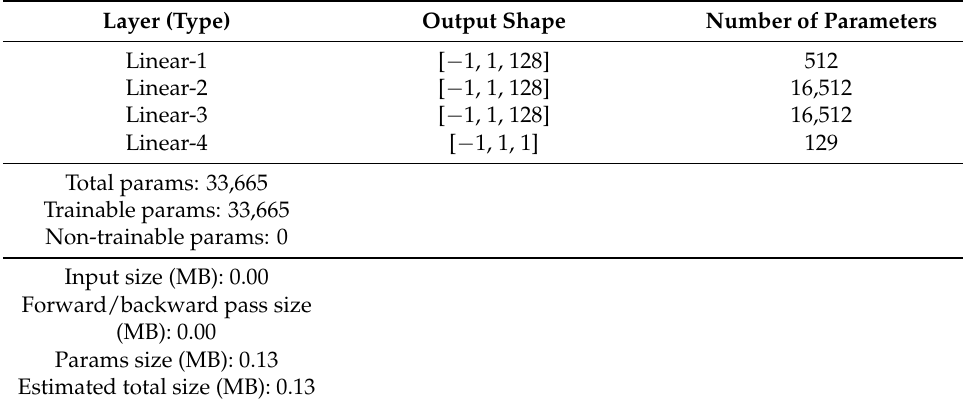
Table 2. The estimation of SIREN network size with three layers.